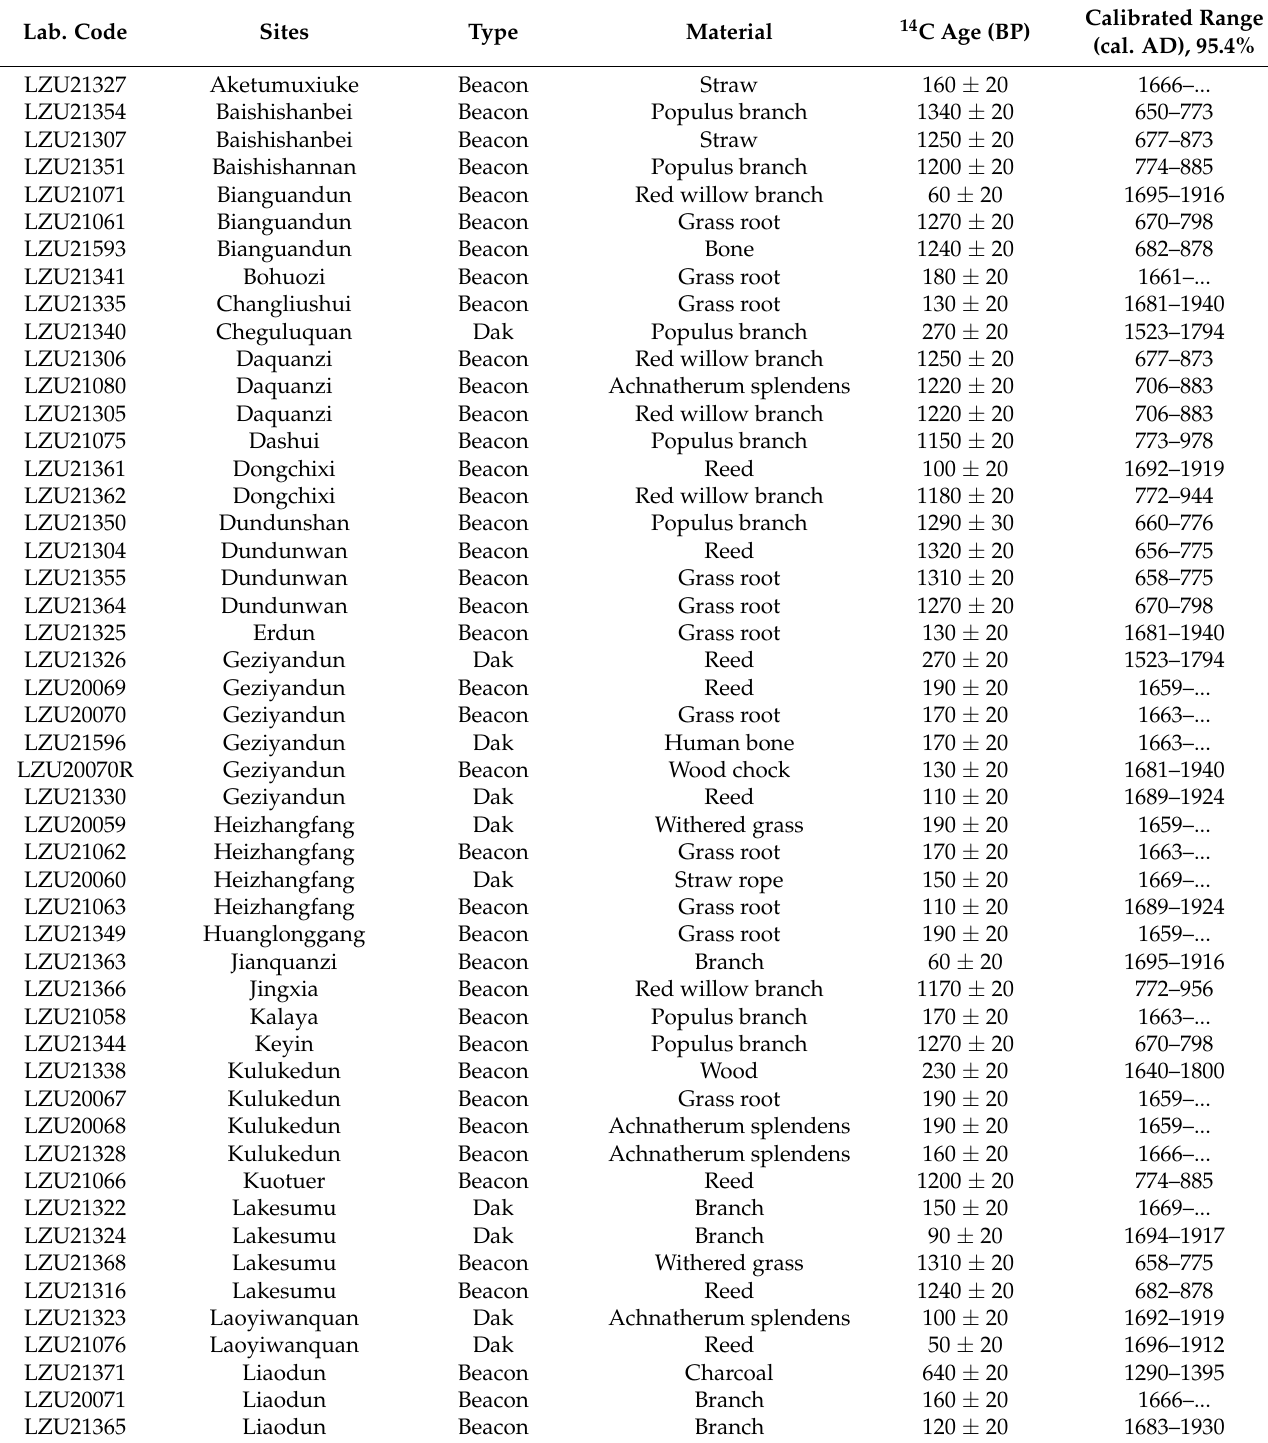
Table 1. Radiocarbon dates of beacon towers and dak ruins in Hami